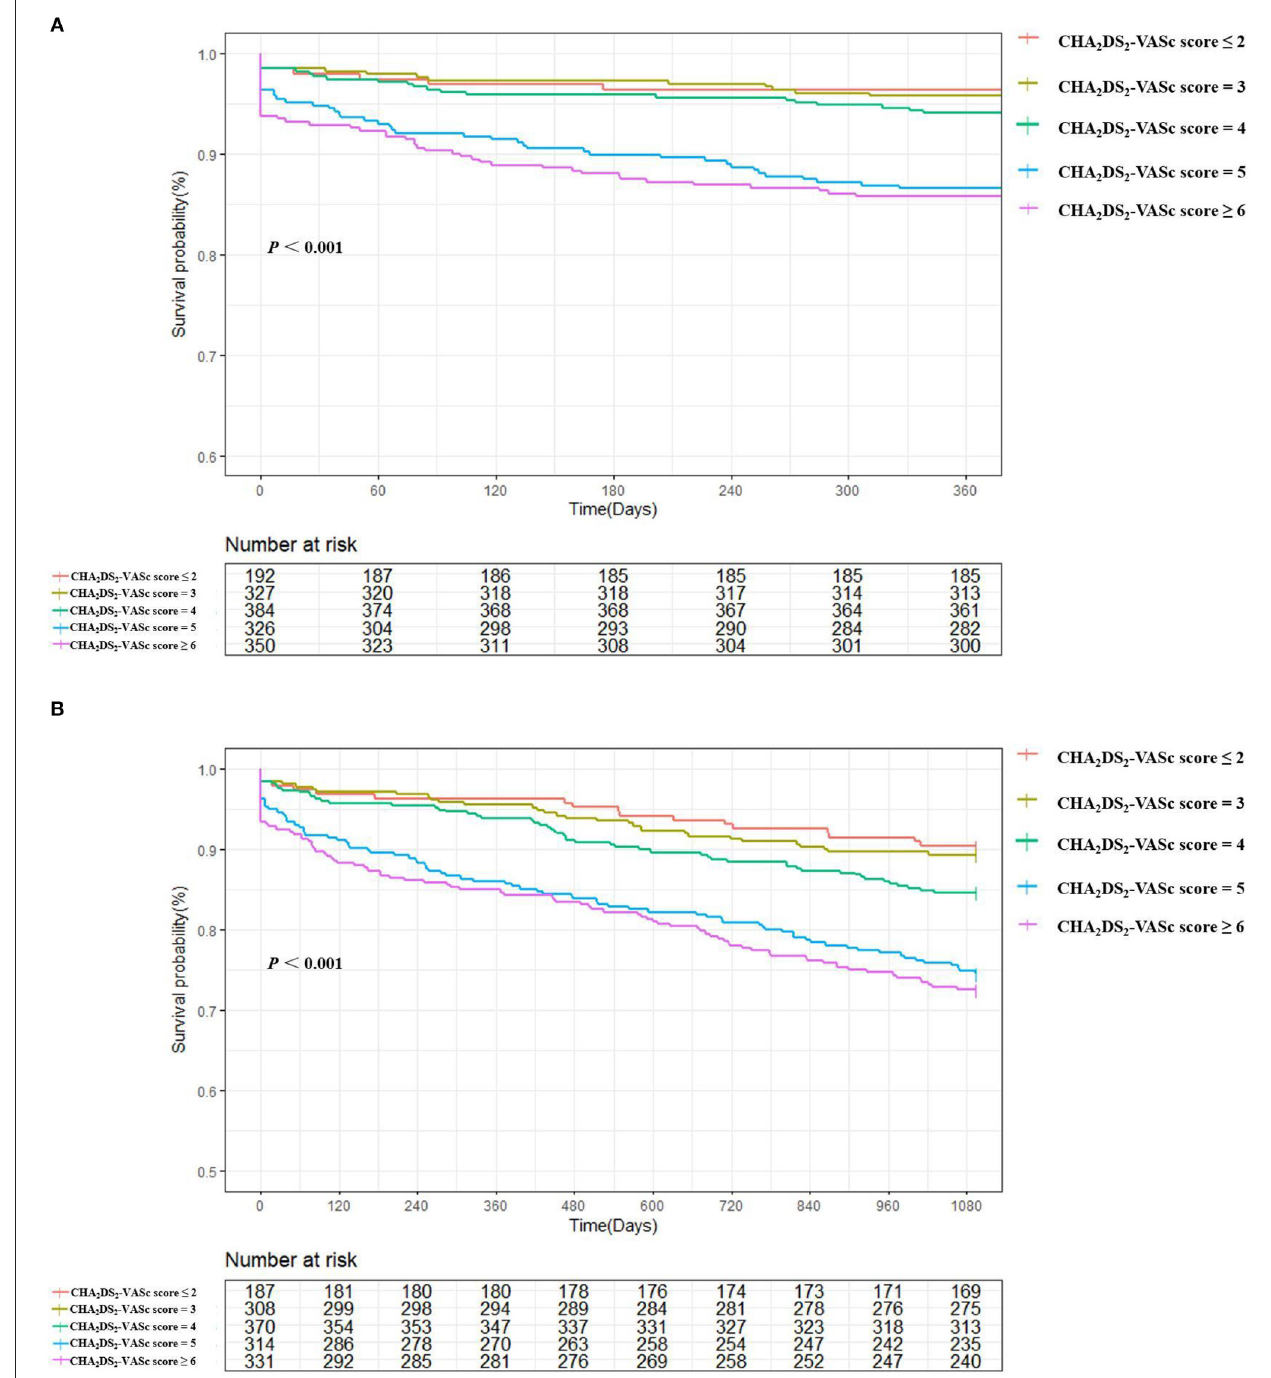
FIGURE 3 | 1-year (A) and 5-year (B) survival in based on Kaplan–Meier survival analysis according to CHA 2 DS 2 -VASc score: ≤ 2, = 3, = 4, = 5, and ≥ 6. Increasing CHA 2 DS 2 -VASc scores were directly associated with reduced survival (by Log Rank